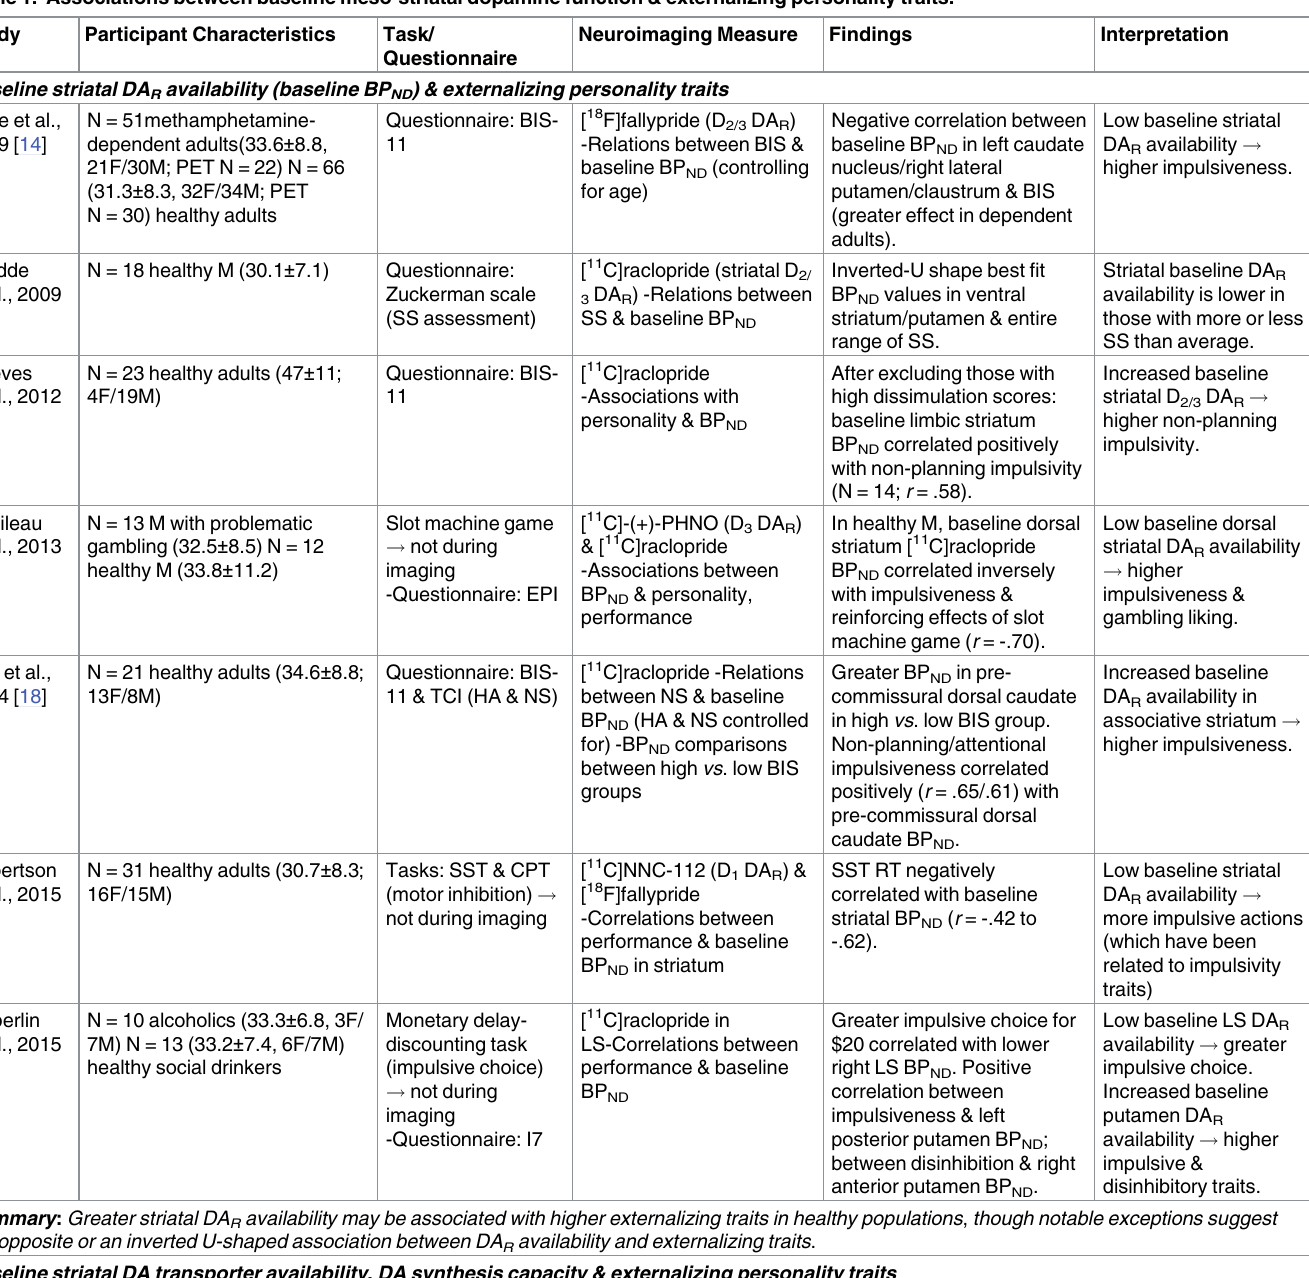
Table 1. Associations between baseline meso-striataldopamine function & externalizing personality